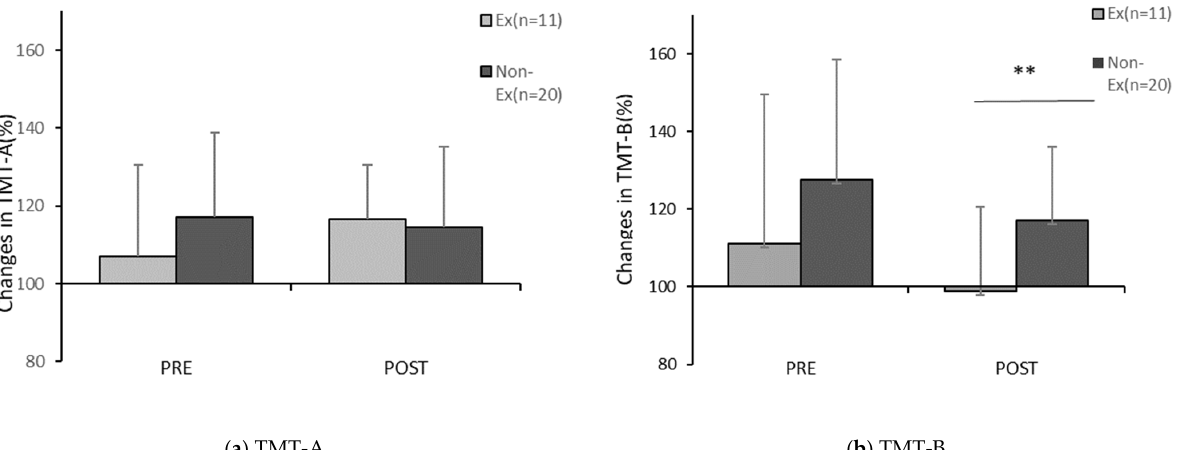
Figure 9. Comparison of changes in the TMT score before and after PX supplementation. Ex: the habitual exerciser group; NonEx: non-habitual exerciser group. Comparison before and four weeks after PX supplementation, ( a ) Changes in TMT-A after PX supplementation, ( b ) Changes in TMT-B after PX supplementation in each trial; Ex vs. NonEx: ** p < 0.05. ( a ) Significant difference between Ex and Non-Ex, pre; n.s. ( p = 0.25, r = 0.21), post; n.s. ( p = 0.76, r = 0.), ( b ) Significant difference between Ex and Non-Ex; pre; n.s. ( p = 0.21, r = 0.23), post: ( p = 0.02, r = 0.41).